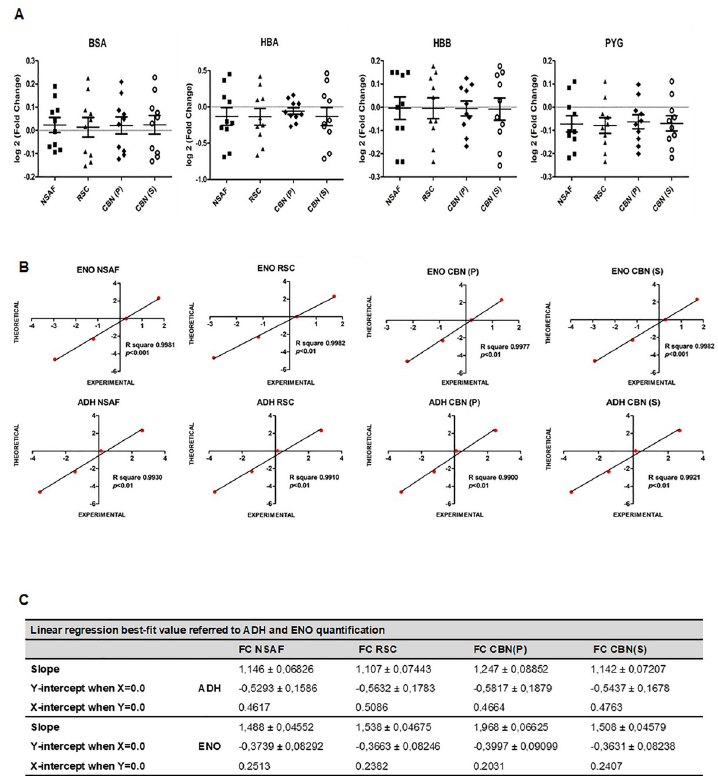
Fig 3. Fold change analysis comparing all spectral counts normalization methods. (A) The mean Fold Change values for unchangeable proteins (BSA, HBA, HBB, and PYG) within the ten different pairs of mixtures calculated by the four normalization methods. The theoretical values are 0 and it is indicated by a point line. (B) Comparison of the experimental and theoretical Fold Change values for the relative quantification of ENO and ADH obtained by using the SpC-based methods and reported in the logarithmic scale. (C) Table reporting linear regression best-fit values for all ENO and ADH linear regressions.